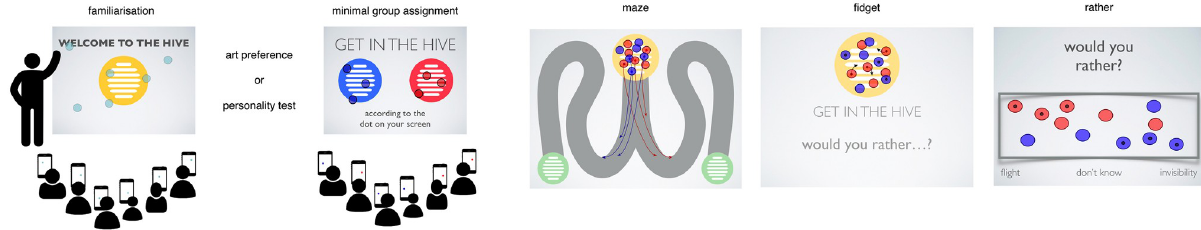
Fig 1. Schematic of experiment set up and minimal group assignment. In each task, confederate dots are shown here with black dots in the middle, though to participants, they were indistinguishable from their own. The ‘rather’ task used images to illustrate ‘flight’ and ‘invisibility’ which have been removed here for copyright